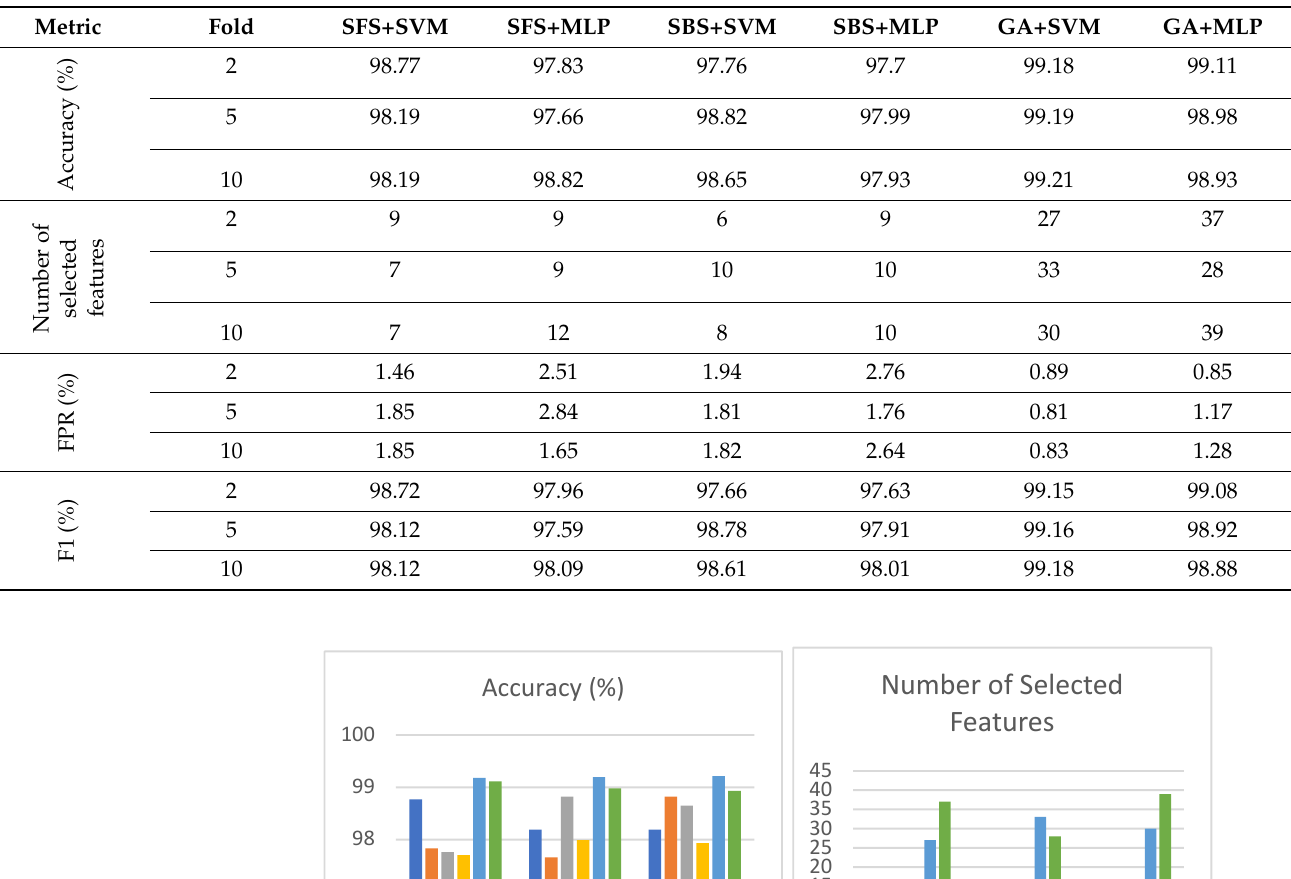
Table 9. Performance of SFS, SBS, and GA using objective function based on DR, FPR, and number of selected features in NSL-KDD.